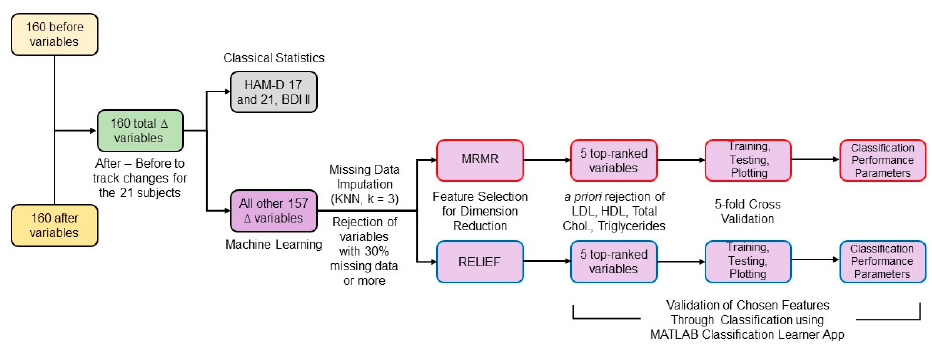
Figure 2. Block diagram of the data analysis workflow.